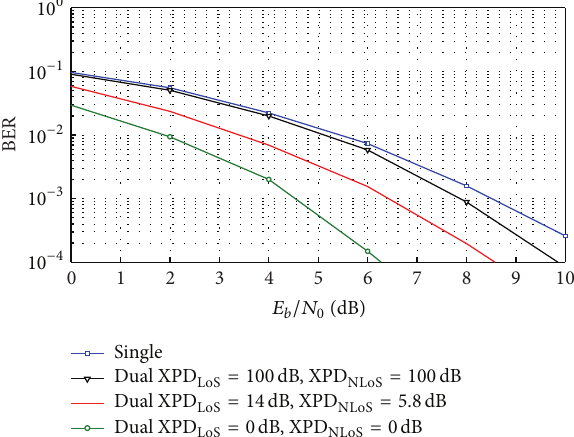
Figure 6: The BER performances for antennas and XPD values under a flat PS 3D fading Rician